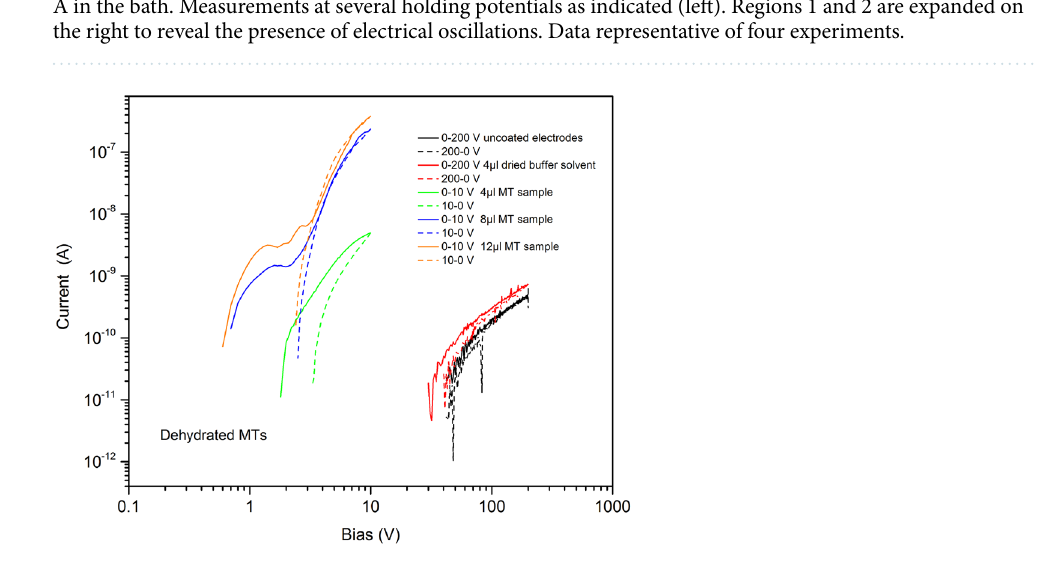
Figure 4. Current versus voltage curves for dried MT samples (formed from different amounts of MT solution). Reference data are shown for both uncoated electrode arrays and dried samples of the buffer solvent only. Measurements taken at room temperature and for both increasing (solid lines) and decreasing (dashed lines) applied